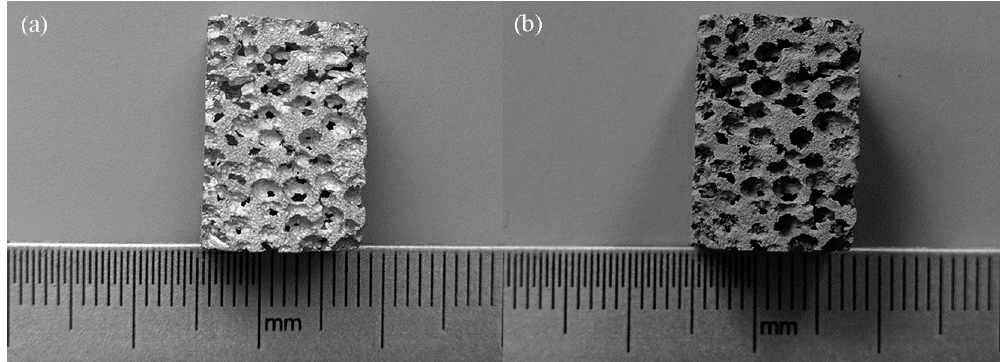
Figure 1. Image of Al foams: ( a ) before and ( b ) after PEO treatment.